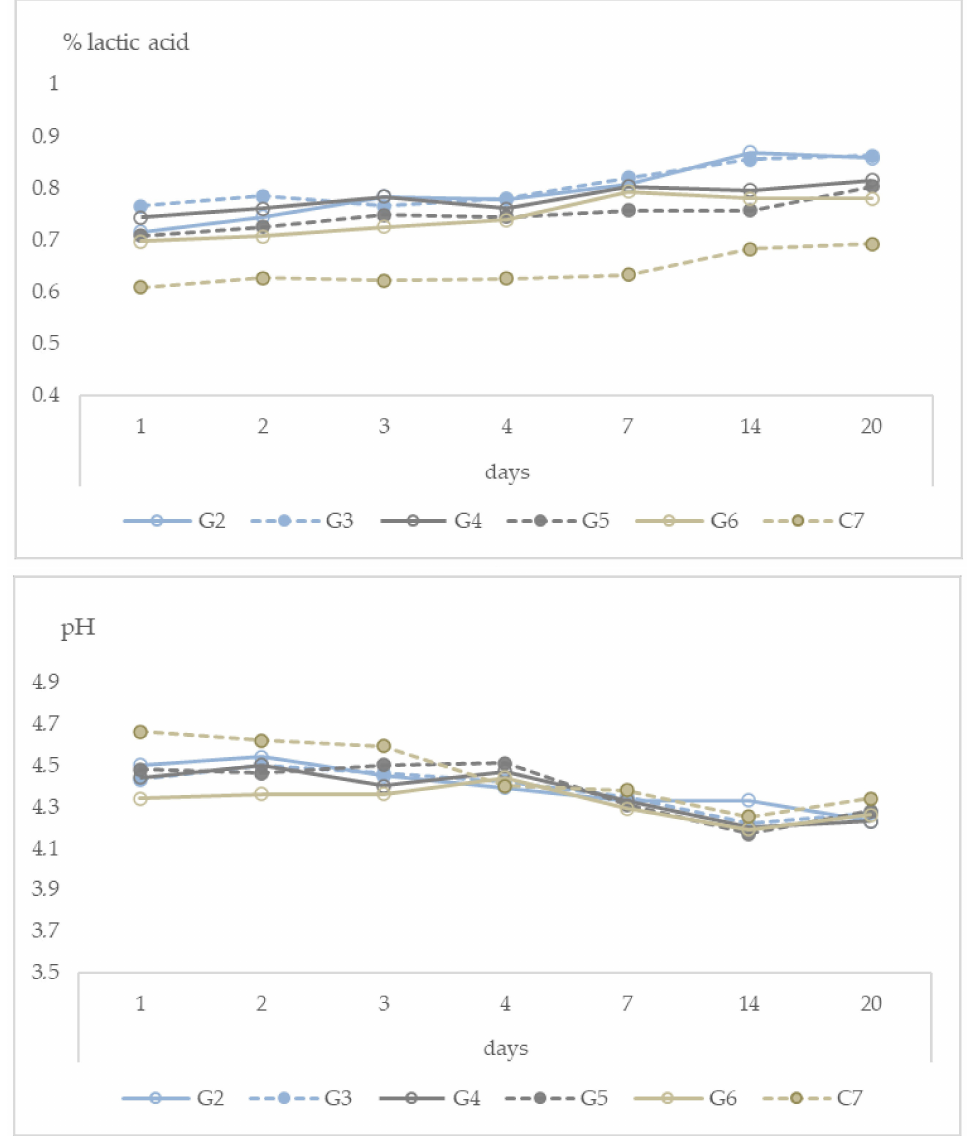
Figure 2. Post-acidification expressed as % lactic acid and pH changes of yoghurt-type gels made from heat-treated homogenized goat milk, after inoculation with yoghurt starter and incubation at 43 ◦ C. G2, 73 ◦ C/16 s; G3, 78 ◦ C/16 s; G4, 85 ◦ C/16 s; G5, 100 ◦ C/16 s; G6, 90 ◦ C/5 min. Control C7, reconstituted cow skim milk powder, 90 ◦ C/5